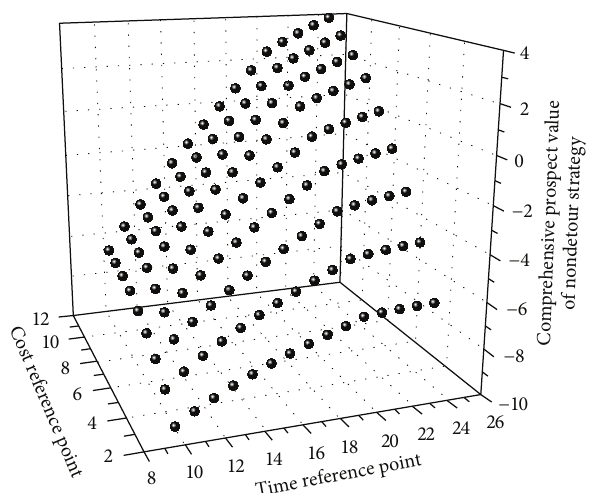
Figure 5: Comprehensive prospect values of different reference points for detour